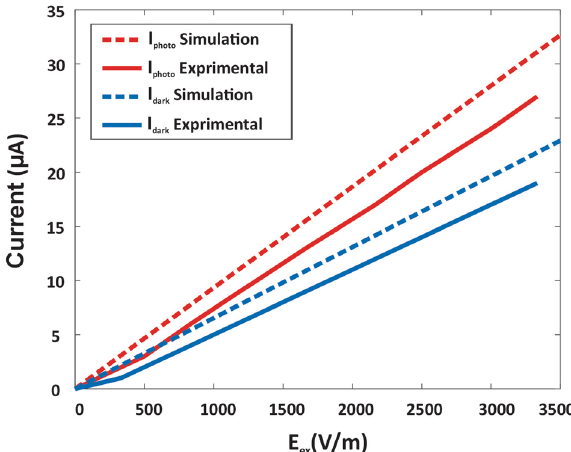
Figure 9. Comparison of simulation and experimental results by measuring the currents for fabricated IR camera. Dark currents and Photocurrents of the theoretical and experimental